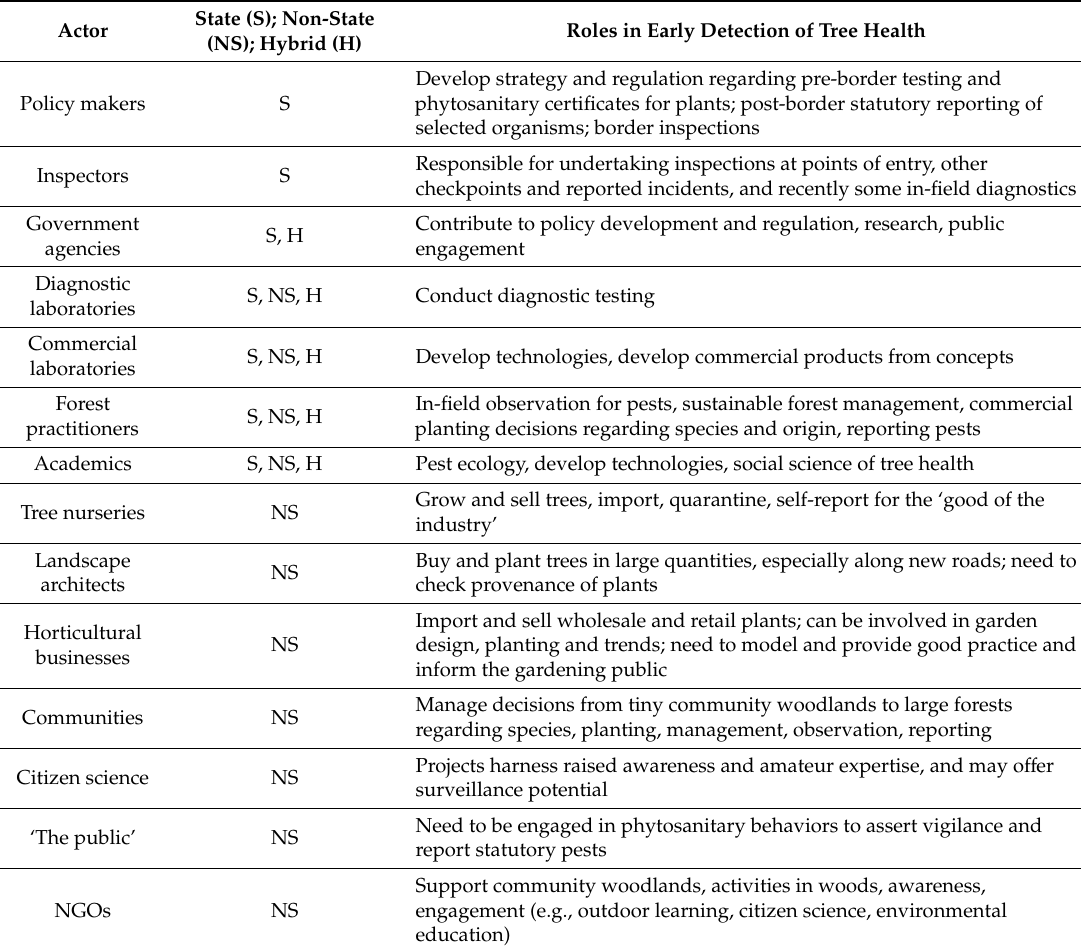
Table 1. Summary of the roles of state and non-state actors in tree health early detection identified throughout the project (from this study and informed by